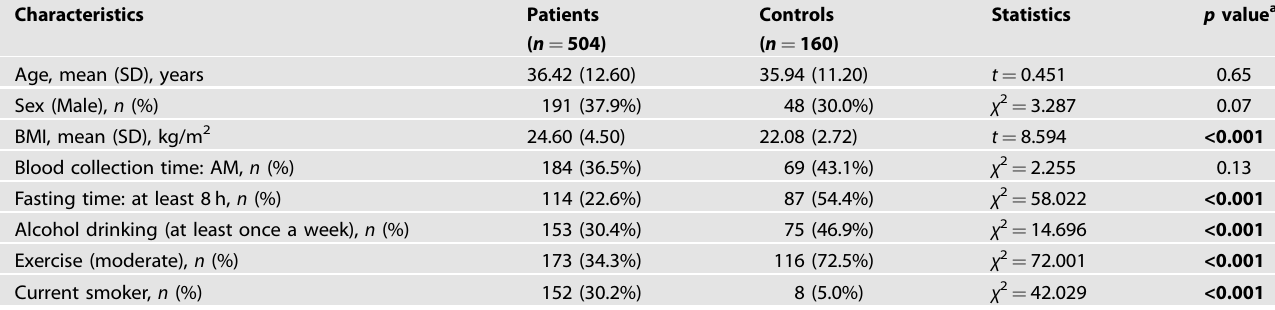
Table 1. Demographics of the study population ( n = 664).